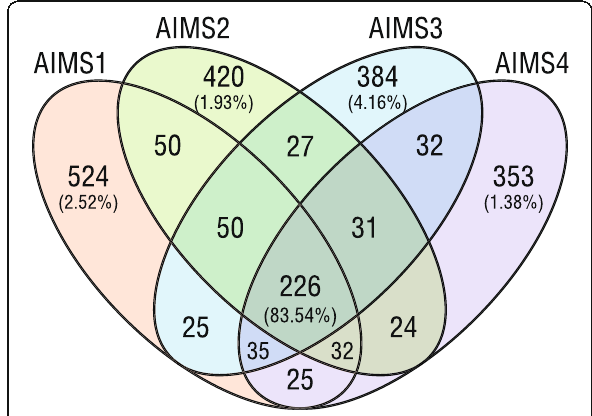
Fig. 1 ASVs common to the AIMS1 – 4 genotypes. The total relative abundance of ASVs unique to each AIMS1 – 4 genotype are shown in